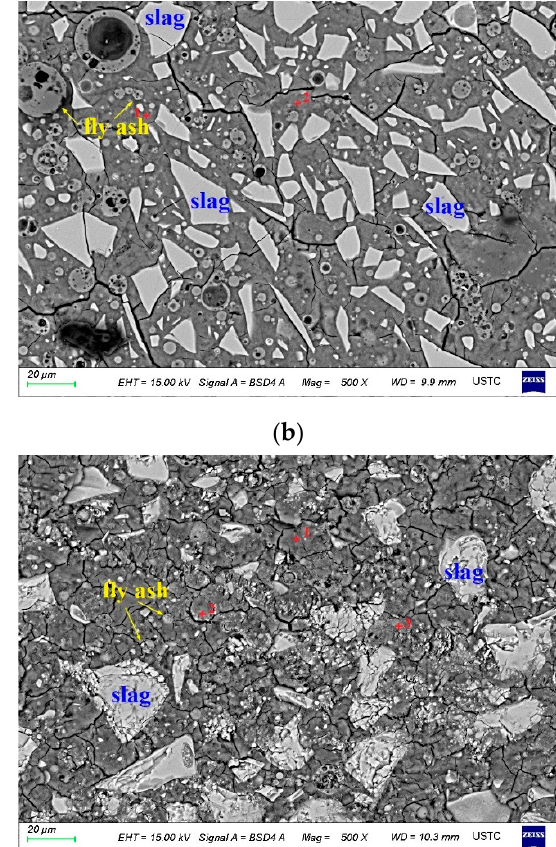
Table 6. Test results of AA-FASM. Numbers